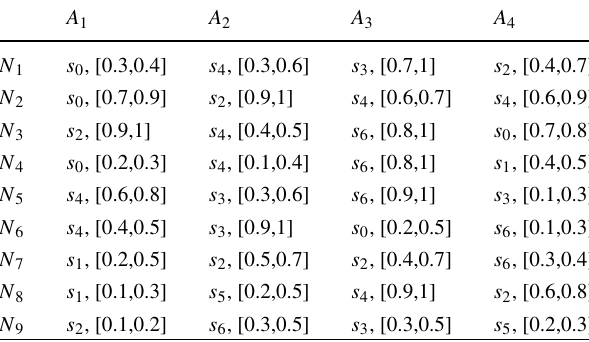
Table 6 The decision matrix with confidence interval values according to the fifth voting